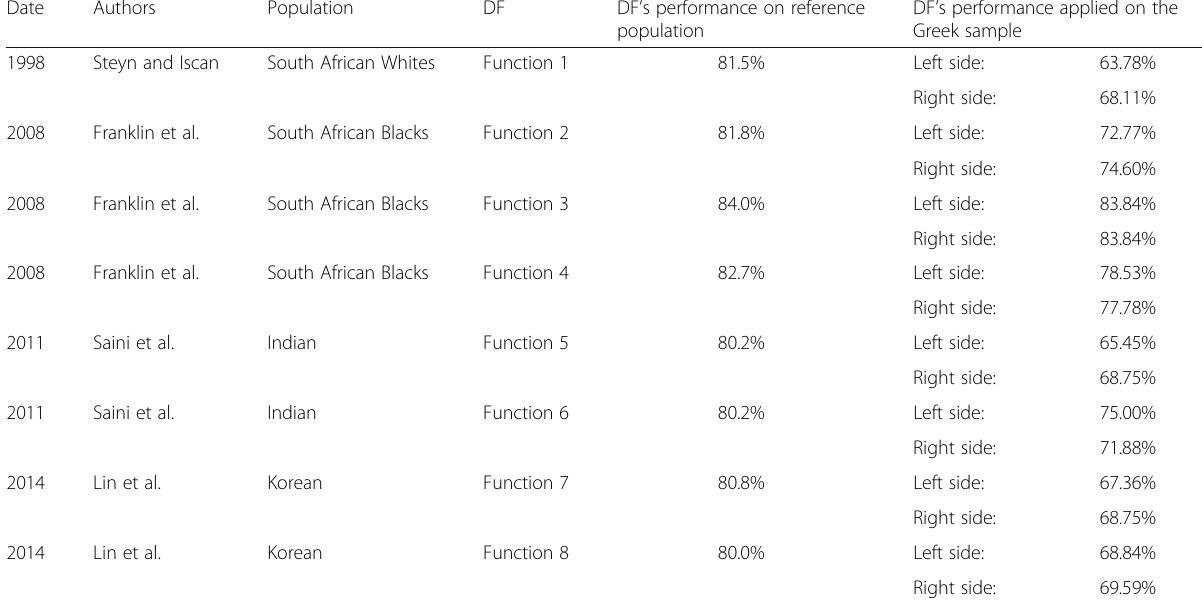
Table 7 The accuracy of other researchers ’ equations as well as their accuracy when applied on the Greek population